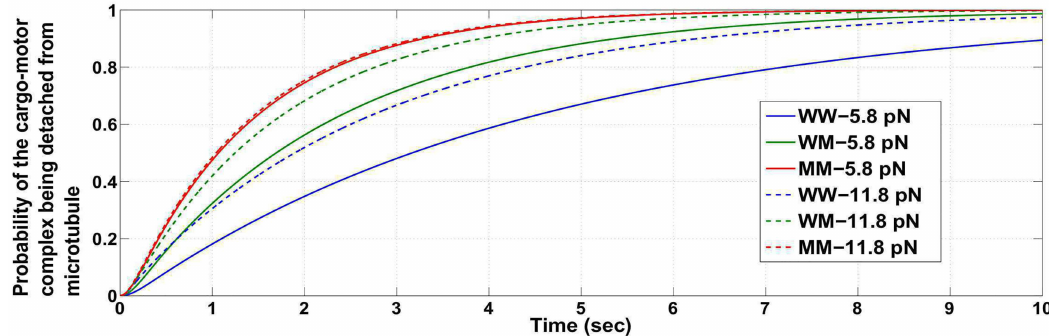
Fig 3. Probability of the cargo-motor complex getting detached from the microtubule, for ensembles WW, WM and MM at load forces close to but less than F s and 2 F s ( F s = 6 pN ).